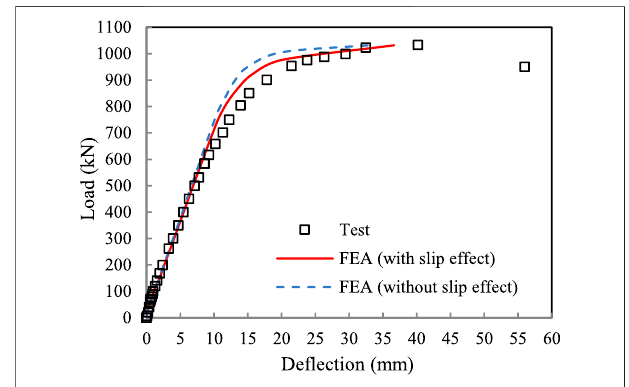
FIGURE 7 | Comparison of calculated and tested values of the load- de fl ection